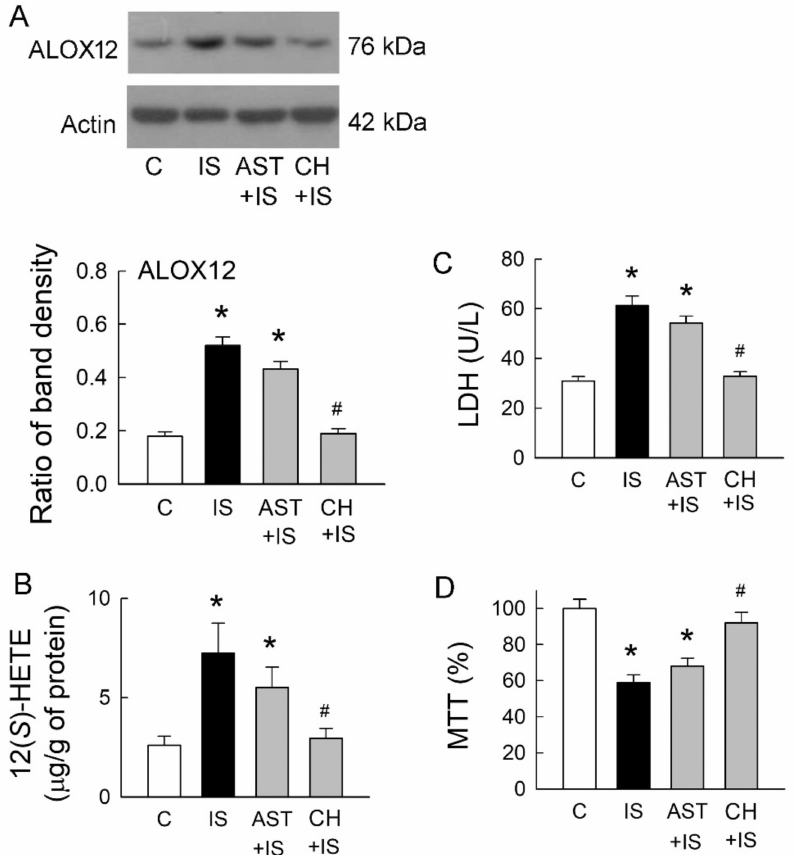
Figure 5. E ff ects of uremic toxin adsorbent (AST-120) and aryl hydrocarbon receptor (AhR) inhibitor on IS-treated cells. ( A ) Representative blots show the protein expression of ALOX12 in MDCK cells treated with IS (5 mM), uremic toxin adsorbent AST-120 (AST, 2 g / mL), AhR inhibitor CH-223191 (CH, 10 µ M), and a combination of these drugs using 20 µ g of the total protein in each lane. The lower bar graphs show the ratio of ALOX12 to β -actin ( n = 6 per group); ( B ) Changes in 12( S )-HETE levels in cells were determined by an enzyme-linked immunosorbent assay; ( C ) Lactate dehydrogenase (LDH) was determined as a marker of cell injury; ( D ) Cells were cultured for 72h in the presence of the indicated agents, and the viability was measured in an MTT assay. n = 6 of experiments performed in each group. * p < 0.05 versus the control group (C), # p < 0.05 versus IS